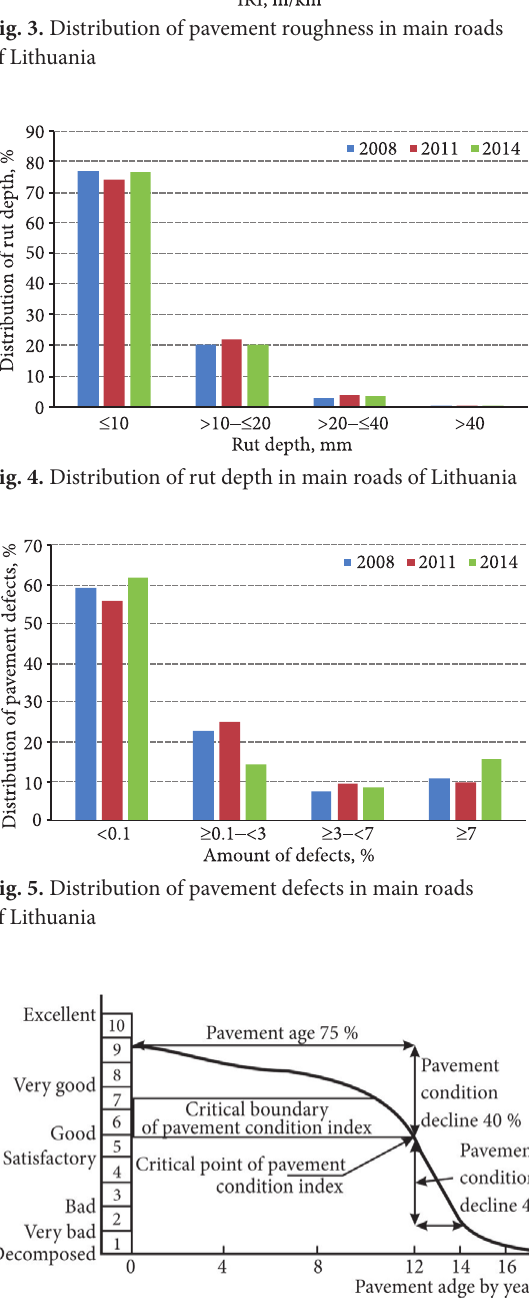
Fig. 6. Pavement maintenance dependence on Pavement Condition